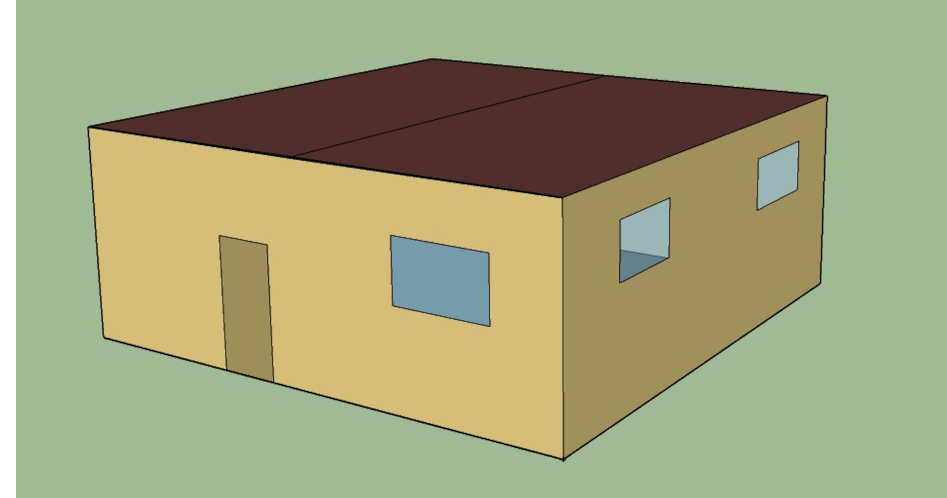
Figure 1. The sketchup model construction used for EnergyPlus as the single zone house.